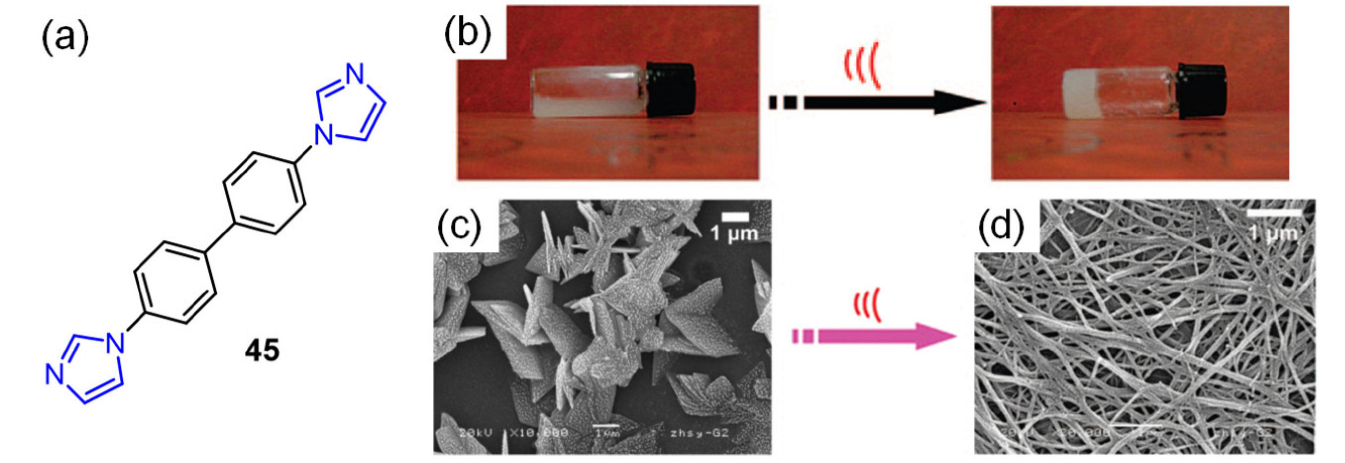
Figure 20. ( a ) Chemical structure of the ligand 45 ; ( b ) coordination polymer {Zn( 45 ) 2 (OTf) 2 }n in MeOH: the suspension before sonication (left), and the gel after sonication (right); ( c ) sheet-like microparticles of {Zn( 45 ) 2 (OTf) 2 }n; ( d ) SEM image of the xerogel. Reprinted with permission from Ref. [83]. Copyright (2009), American Chemical